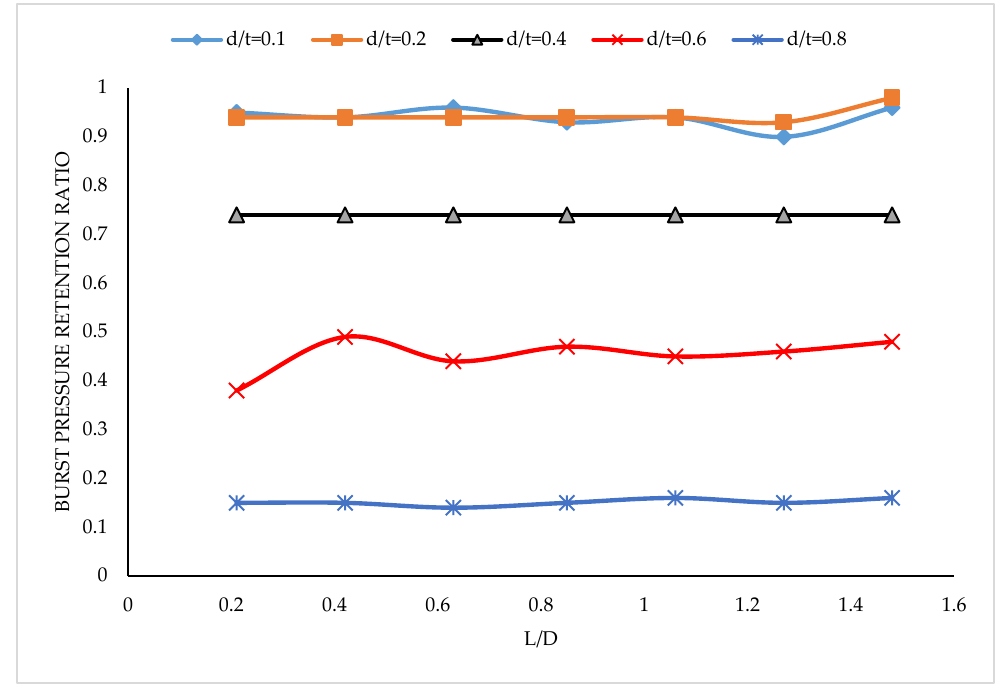
Figure 10. Variation of the burst pressure retention ratio with L/D for 863.6 mm diameter and 9.63 mm thick pipe for various d/t .